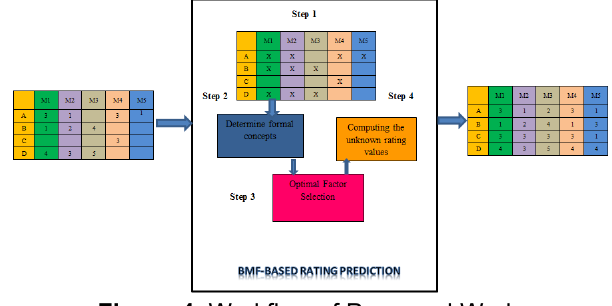
Figure 4. Workflow of Proposed